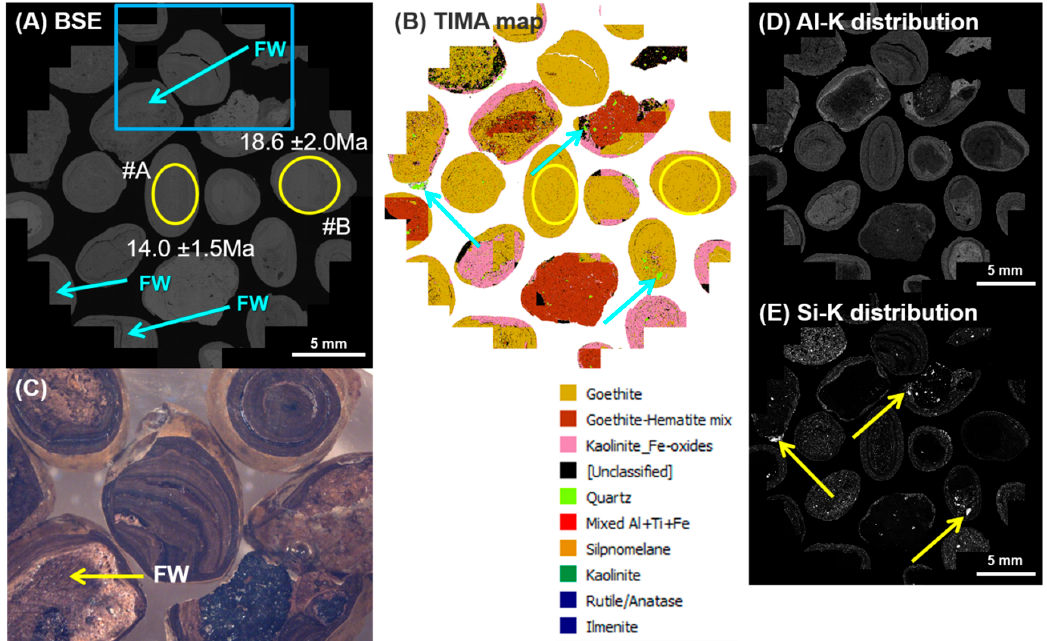
Figure 19. Composite backscattered electron (BSE) ( A ) and TIMA ( B ) mineral distribution map of the PPS (#25451) used to locate areas suitable for (U–Th)/He-dating (areas #A and #B circled in yellow). The blue box in ( A ) frames the view of pisoliths shown in more detail in the optical image ( C ). Wood fragments (FW), replaced by Fe oxides, comprise the core of the pisolith (arrowed in A and C ). Element maps of the Al ( D ) and Si ( E ) distribution also aid in identifying areas suitable for (U–Th)/He-dating. Bright, white-contrast specks in the Si–K map (high Si content— E , yellow arrows) indicate the presence of quartz.